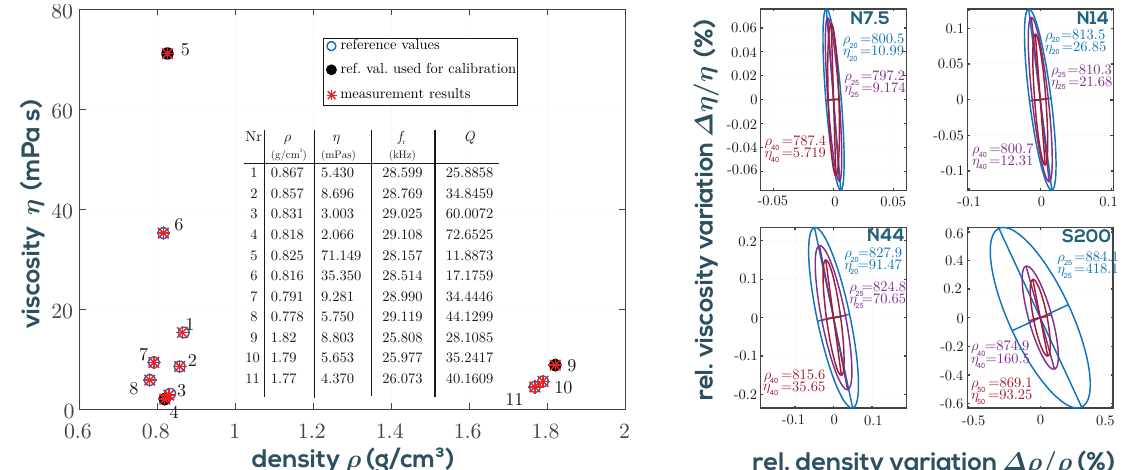
Figure 5. Left : The fluid model in Equation (4) is adjusted using three fluid standards (filled dots No. 4, 5, and 9). The calibration is verified for eight additional fluids. Right : Relative deviations due to measurement noise. Error ellipses showing three times the standard deviation are plotted for fluid standards (N7.5, N14, N44, and S200 from Cannon) at three different temperatures each. Units of density and viscosity are kg/m 3 and mPas,